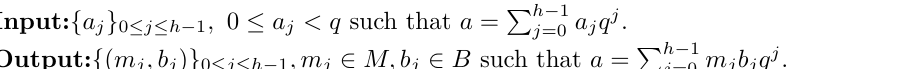
Algorithm 6 Scalar conversion